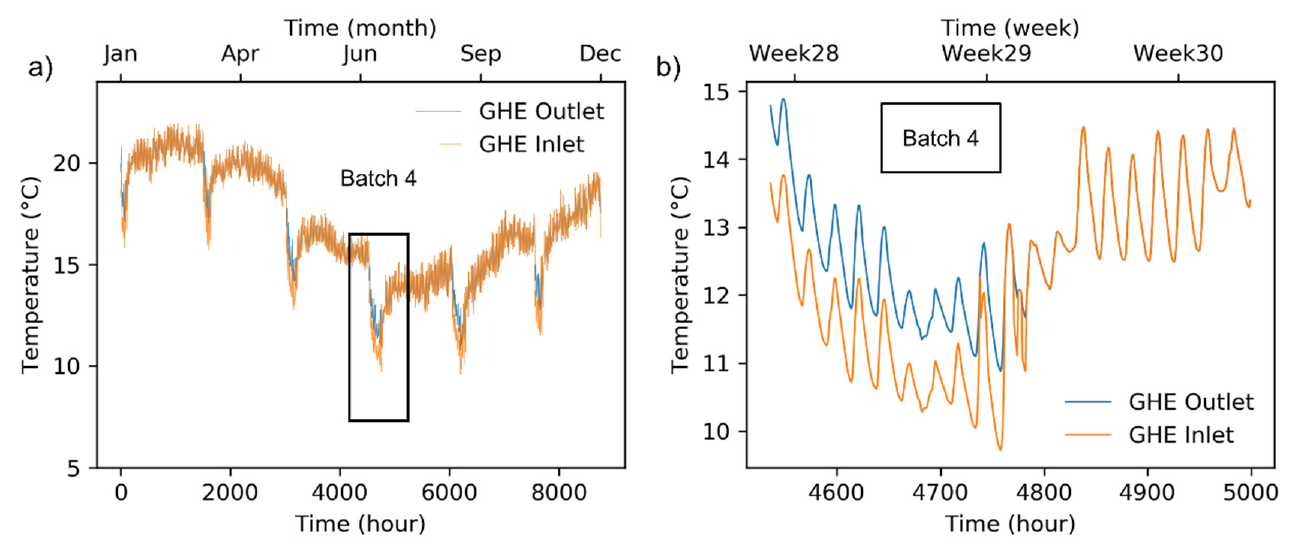
Figure 5. Outlet and inlet temperatures of the FEM-simulated GHEs: ( a ) results for one TMY; ( b ) results for batch 4.(system turned off at about 4800 h, ~12 days of heating in this batch).